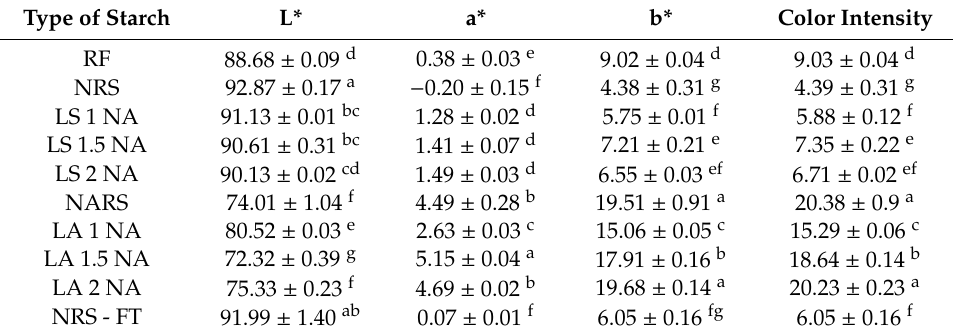
Table 5. Color spectra of the RD31 rice flour, native starch, and modified starches.